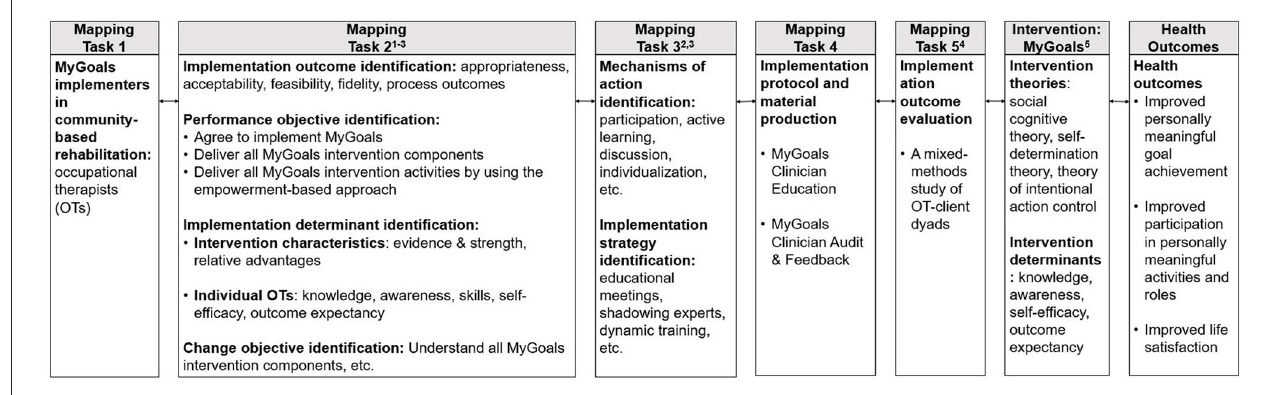
FIGURE 1 | The working conceptual model for MyGoals implementation strategy development and evaluation. Guiding theories, models, and frameworks: (1) Social cognitive theory, (2) A taxonomy of behavior change methods, (3) CFIR, (4) Proctor’s implementation research framework, (5) Intervention Mapping.